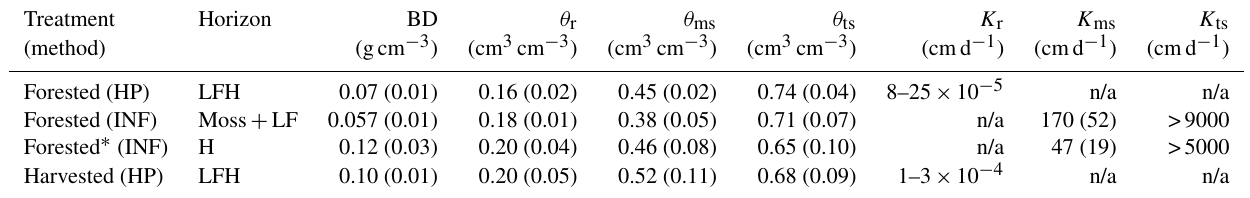
Table 4. Average soil hydraulic parameters of organic horizons. Data were obtained from the HYPROP (HP) evaporation apparatus for unsaturated conditions and falling head infiltration (INF) tests for matrix-saturated and totally saturated (macropore infiltration) conditions. Both tests were made on intact cores and standard deviations are provided in parentheses ( n = 6). Live and senescent moss was removed for the HP analysis but not the INF analysis (see “horizon” column). BD: bulk density; θ r : water content at residual saturation; θ ms : water content at matrix saturation; θ ts : water content at total saturation; K ms : hydraulic conductivity at matrix saturation; K ts : hydraulic conductivity at total saturation. Results from INF were used to calibrate continuous field measurements (see Table S8). Treatment